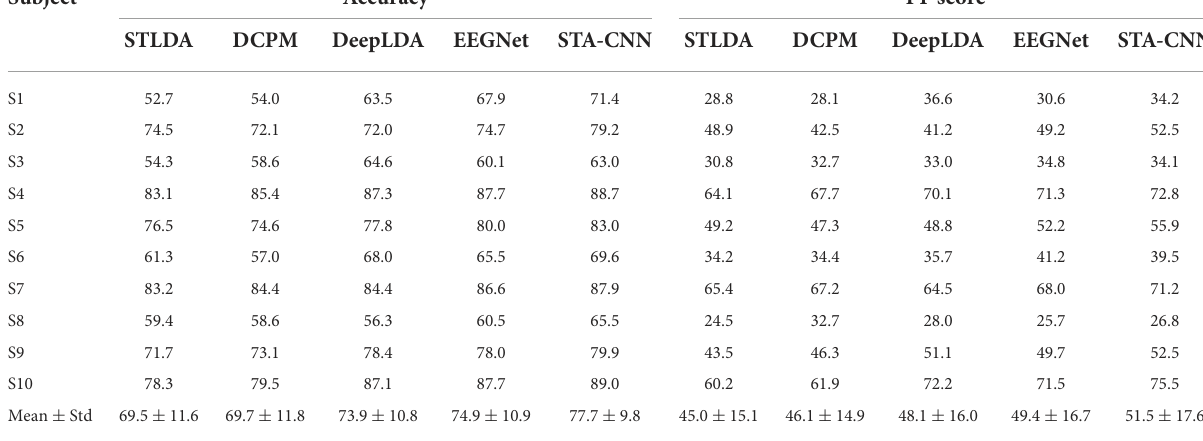
TABLE 3 The classification accuracy and F1-score of 10 subjects using five methods in the second stage (%).